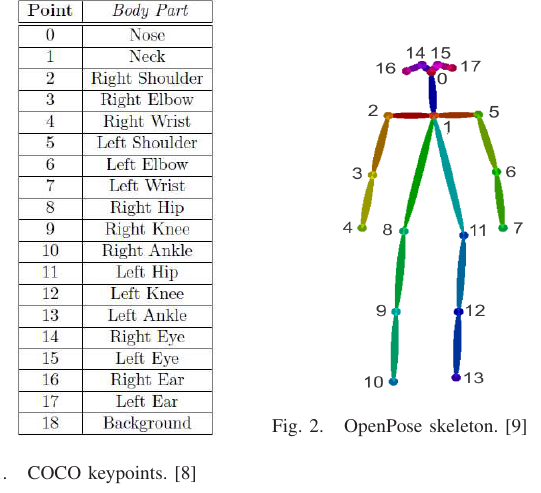
Fig. 2. OpenPose skeleton. [9]